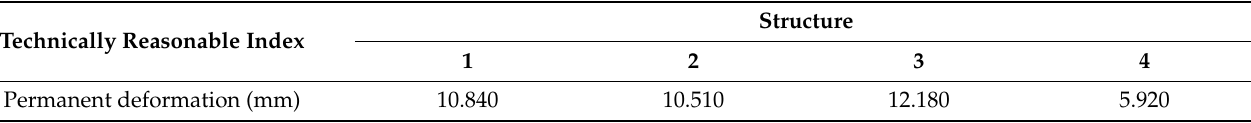
Table 13. Asphalt mixture layer permanent